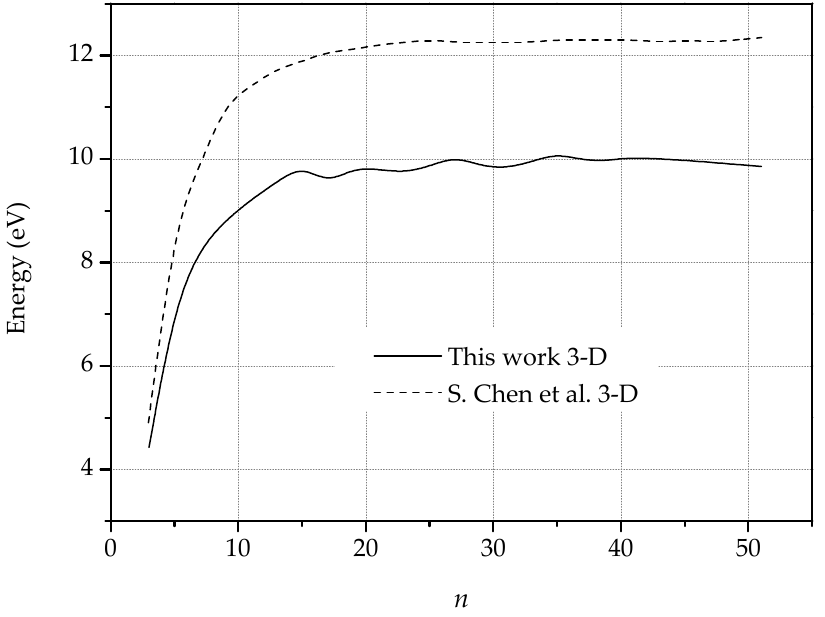
Figure 8. Dislocation energy as a function of the size of the dipole for the 3-D fully relaxed configurations compared with the results presented by Chen et al.